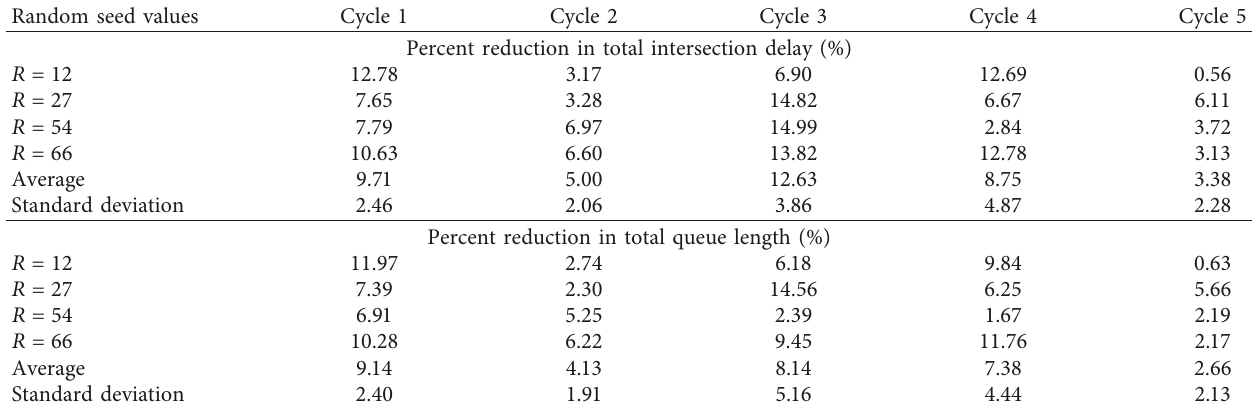
Table 4: Percent comparison of Model I relative to Webster’s design across different random seed values.